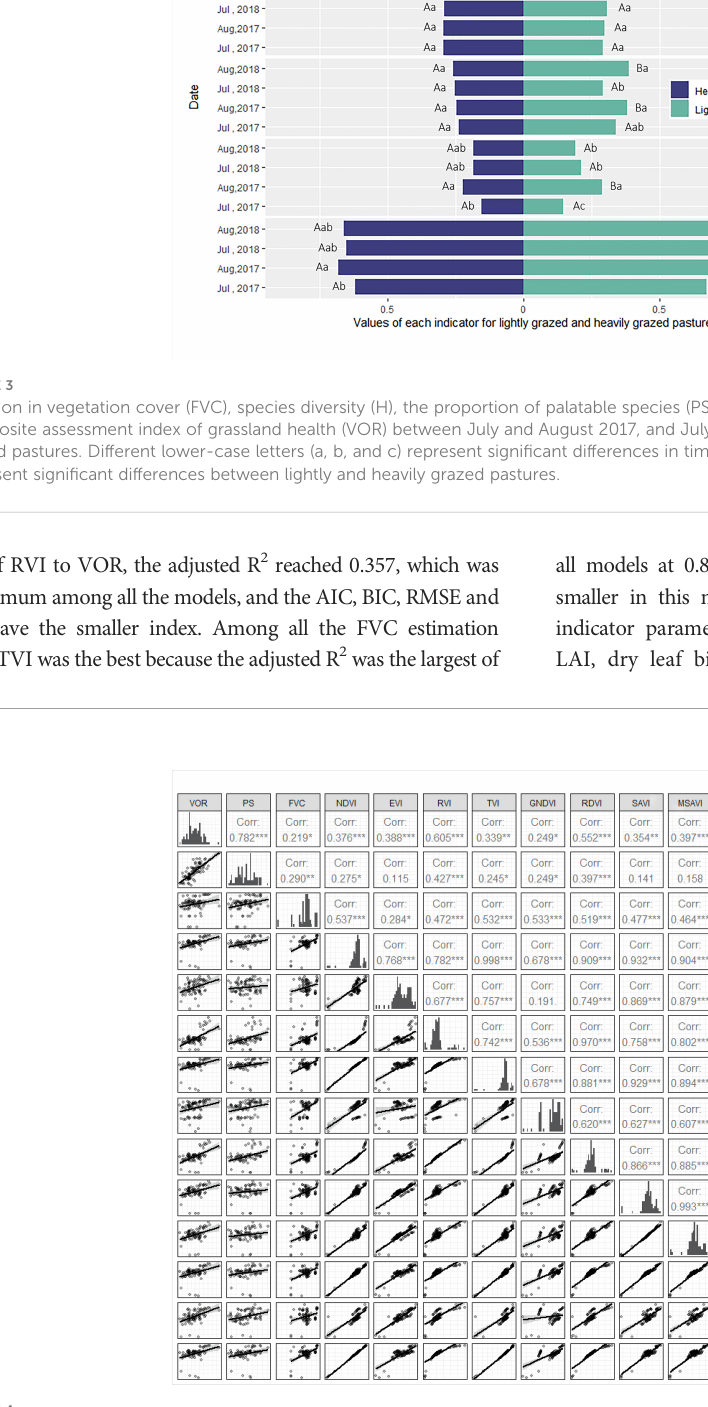
FIGURE 4 Correlation between indicators and vegetation indices. ***, **, * indicate a signi fi cant level of 1%, 5% and 10%, respectively.